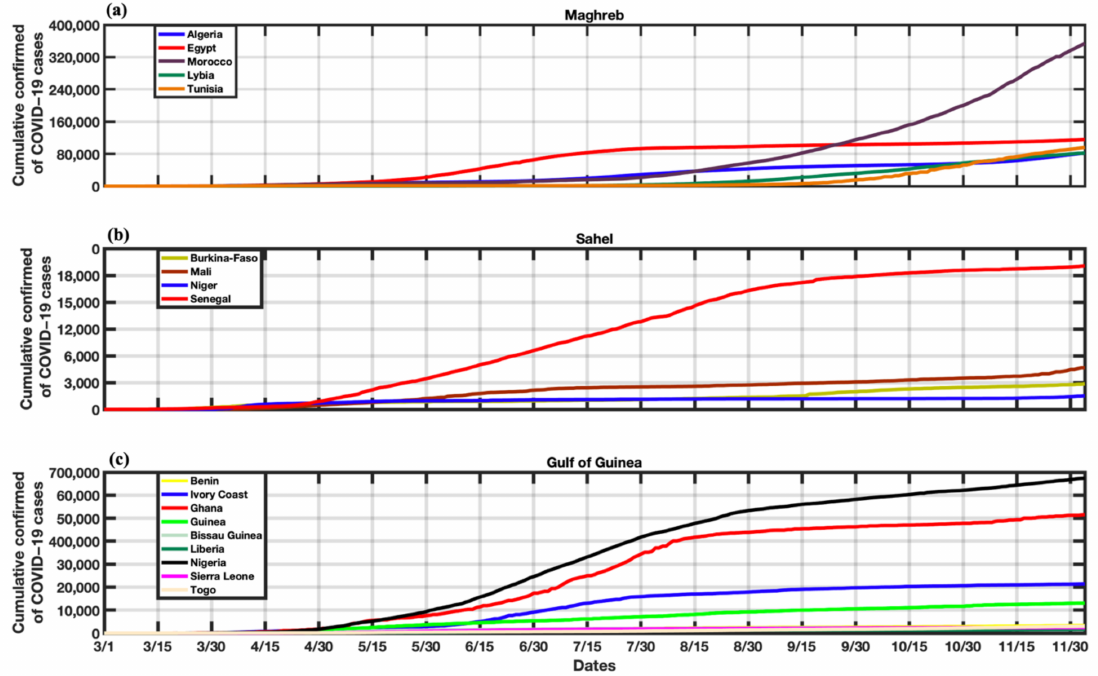
Figure 3. Growth curve of the cumulative confirmed COVID-19 cases over ( a ) the Maghreb countries, ( b ) the Sahel countries, and ( c ) the Gulf of Guinea countries (from 1 March to 30 November 2020). Due to the large difference in the amplitudes between the three different African bio-climatic zones, the y -axis is capped at 400,000 cases for the Maghreb, 18,000 cases for the Sahel, and 70,000 cases for the Gulf of